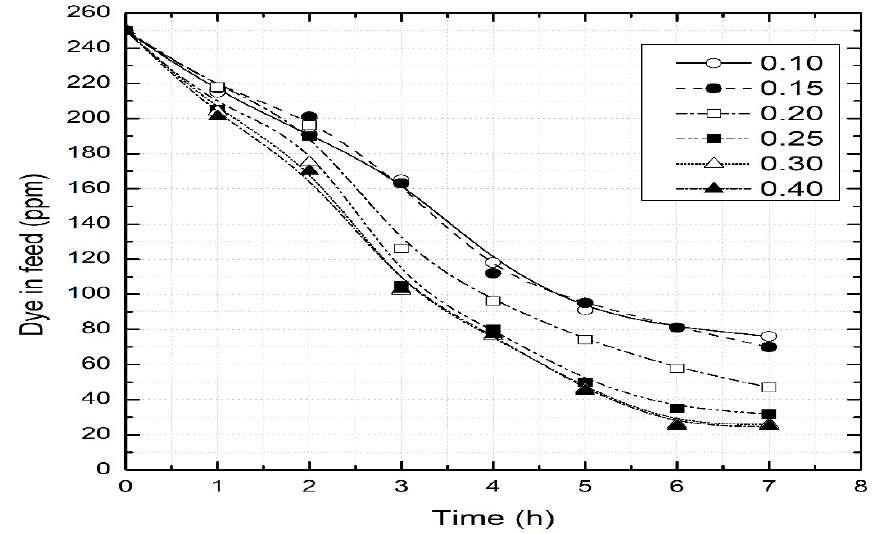
Figure 3. Effect of acid concentration in the stripping chamber. Feed = 100 mg/L dye at pH 11; SLM = sunflower oil; strip = 0.1 M–0.4 M HCl; permeation time = 8 h.